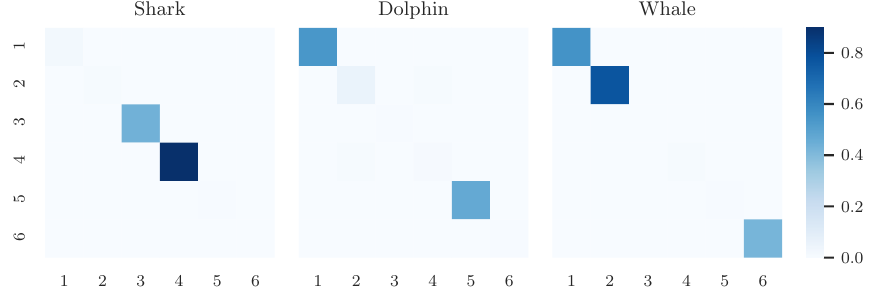
Figure A5. Colored heatmap of affinity tensor R .